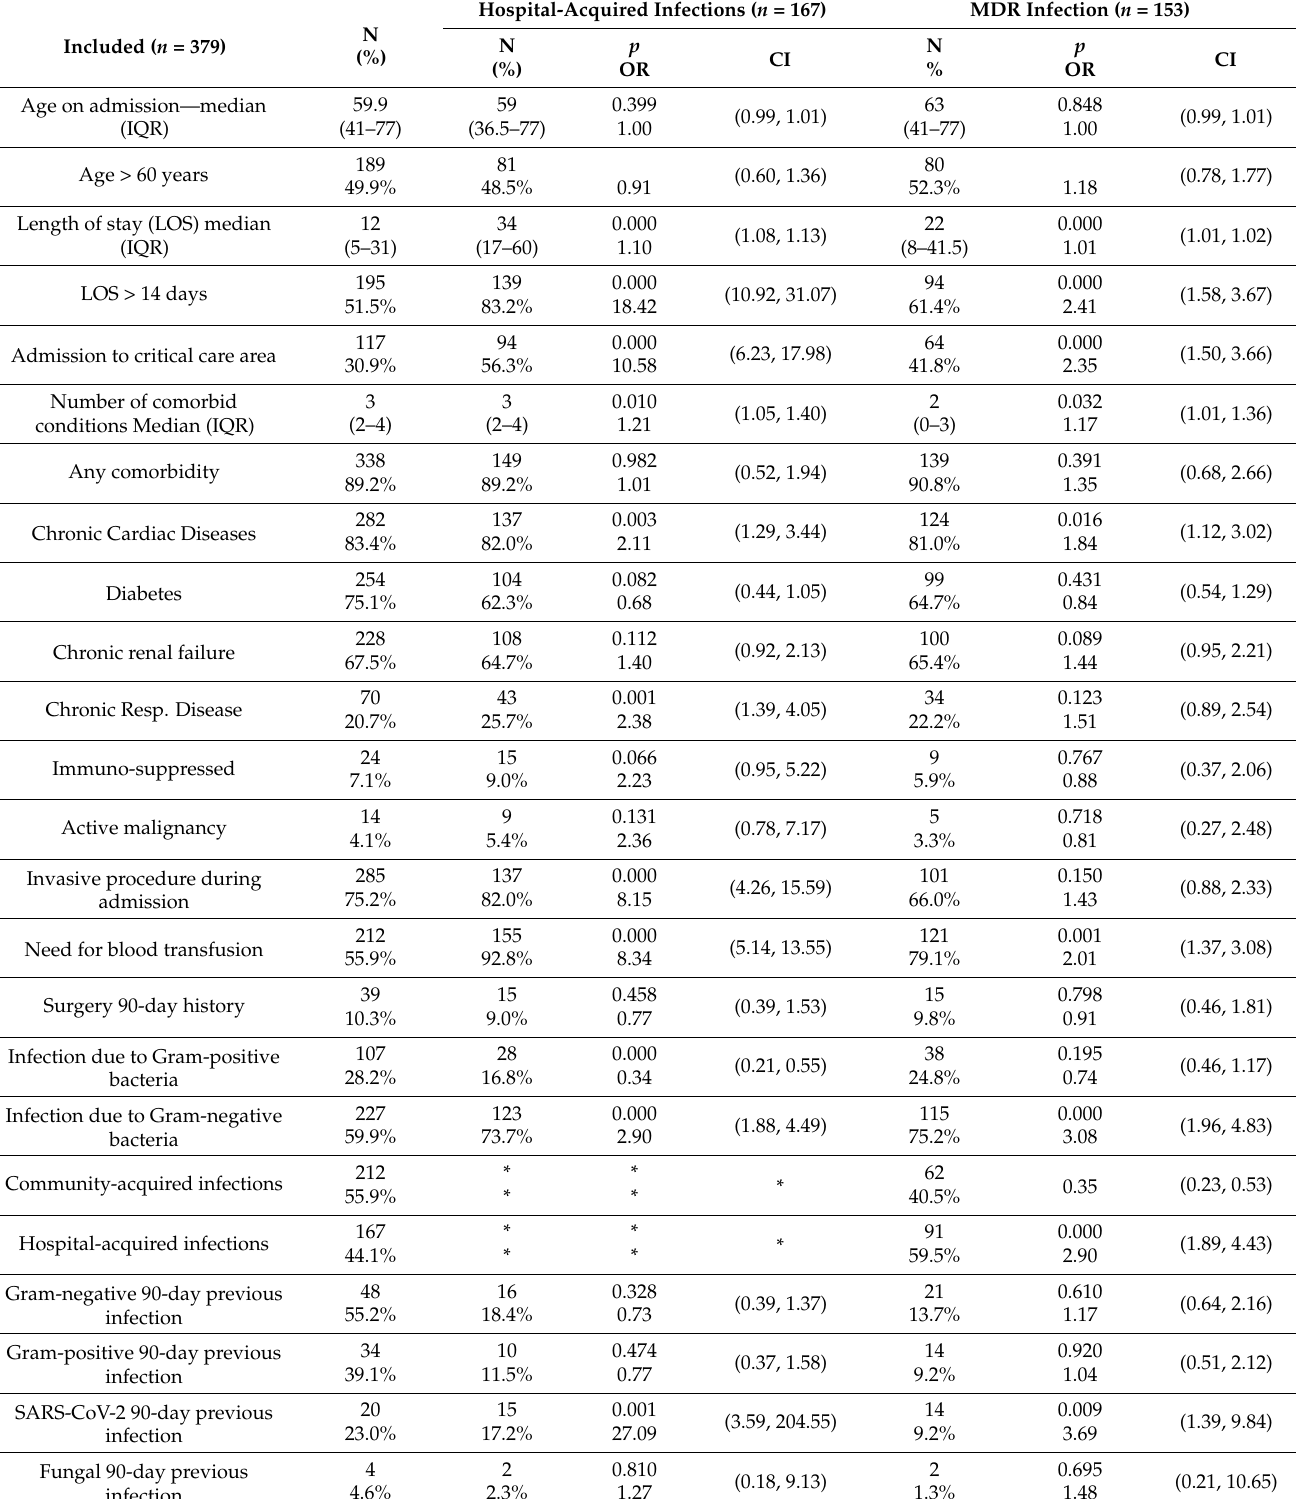
Table 2. Variables related to hospital-acquired infections/acquisition of MDR infections (Binary logistic regression). Check Appendix A for comprehensive statistical